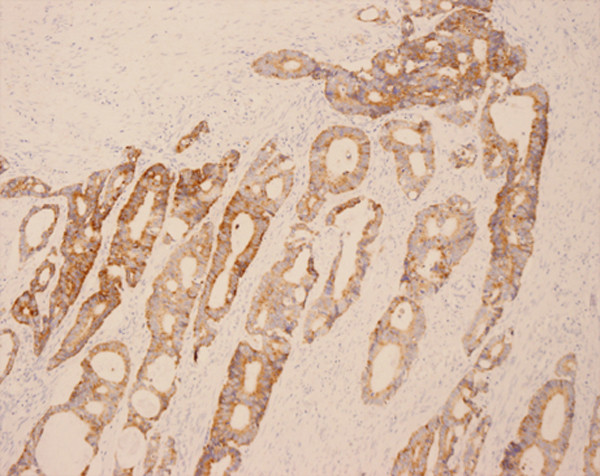
Immunohistochemical staining of VEGF in colorectal cancer (EnVision, ×200). VEGF expression showing a strong cytoplasmic immunostaining.